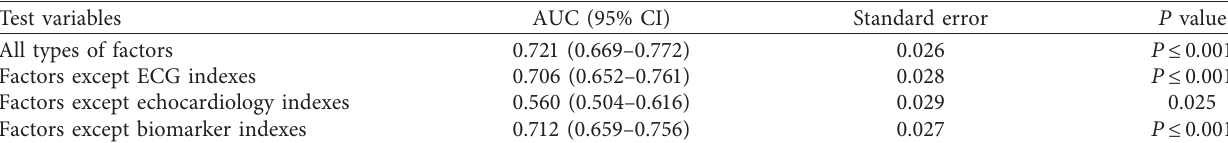
Figure 3: ROC curve of the model group. Table 4: Comparison of AUC of each model.